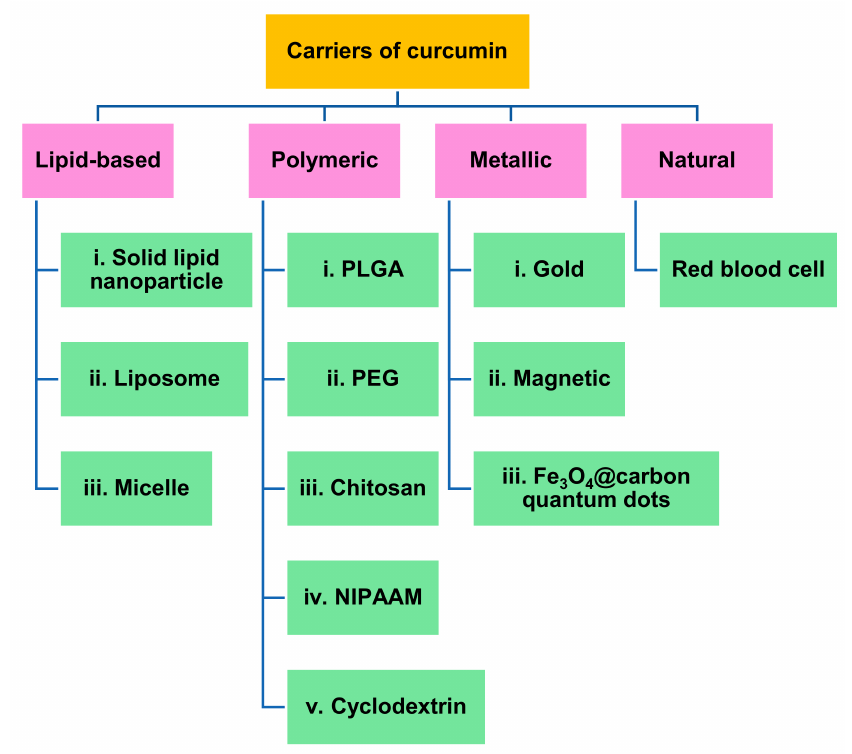
Figure 5. Carriers used for the delivery of curcumin for Alzheimer’s treatment for in vivo studies